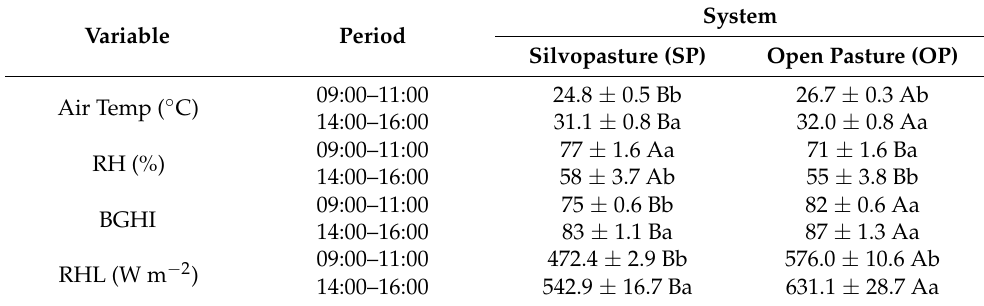
Table 2. Average values (mean ± SEM) of air temperature (Air Temp), relative humidity (RH), black globe-humidity index (BGHI) and radiant heat load (RHL) between the production systems throughout the periods of the day. Variable